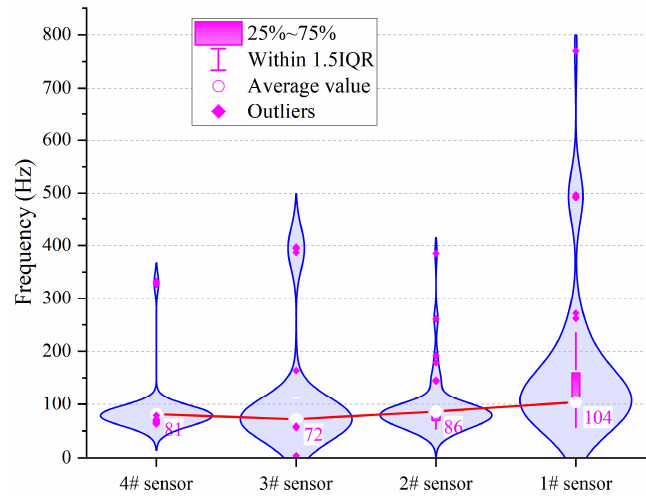
Figure 8. Statistical violin diagram of main frequency.